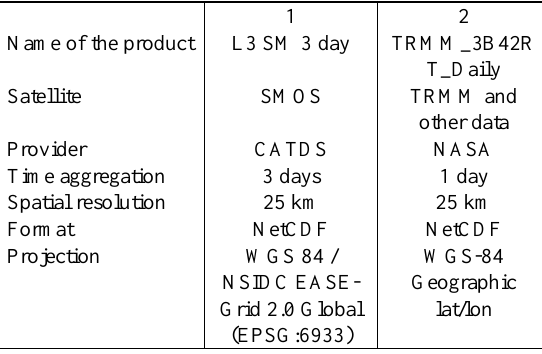
Table 1. Characteristics of the SMOS (1) and TMPA-RT (2) used